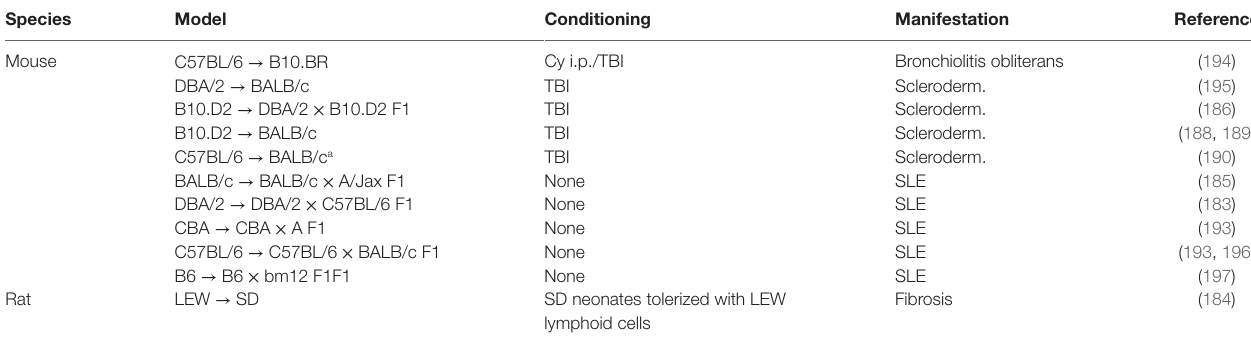
TABLe 2 | Overview of rodent models for chronic